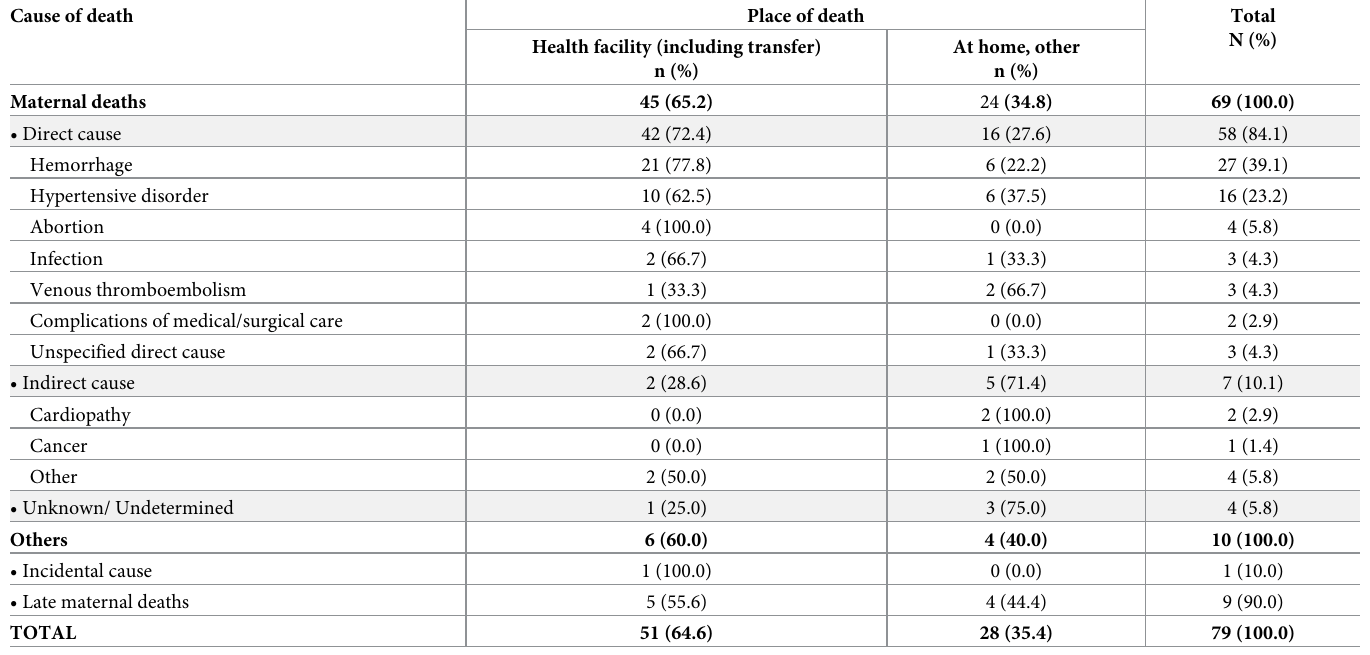
Table 3. Number of maternal deaths and late maternal deaths by site of death and according to group of causes. Cause of death Place of